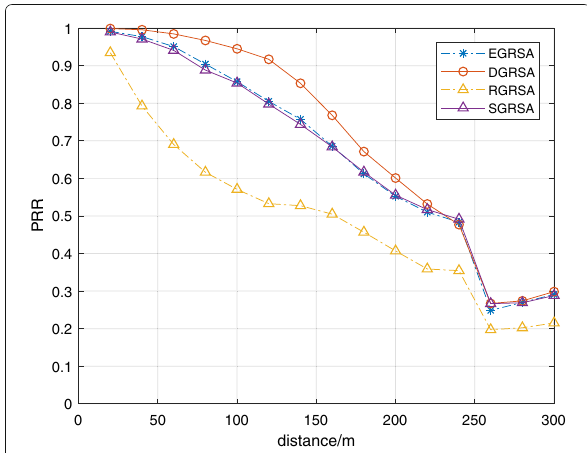
Fig. 16 The PRR of DGRSA when the number of VUEs is 600 in the jam scene. The packet reception ratio (PRR) curve changing with distance when jam areas are areas 1, 2, 7, and 8 and the number of vehicle user equipments (VUEs)is600.Fourgeo-basedalgorithms, namely random geo-based resource selection algorithm (RGRSA), sensing geo-based resource selection algorithm (SGRSA), the proposed enhanced geo-based resource selection algorithm (EGRSA), and the proposed dynamic geo-based resource selection algorithm (DGRSA) are compared in this figure. The line with red circles represents the proposed DGRSA. The line with blue stars represents the proposed EGRSA. The line with purple triangles represents the SGRSA. The line with yellow triangles represents RGRSA